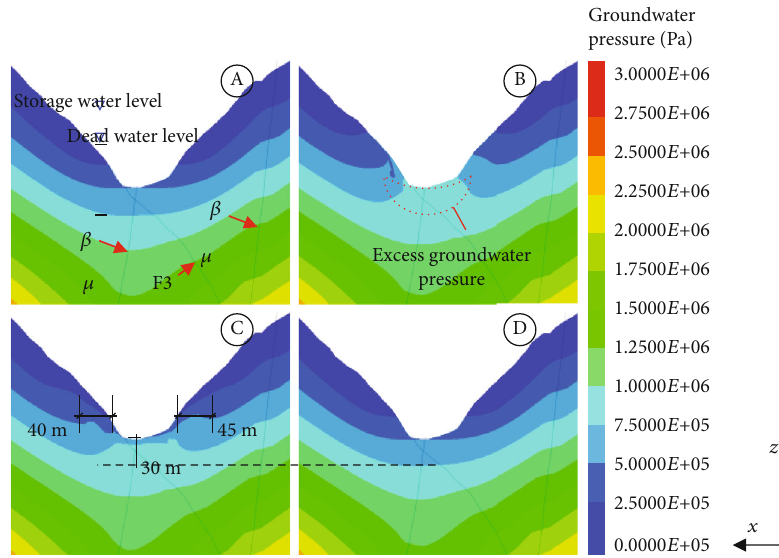
Figure 10: Distribution and evolution of deformations in